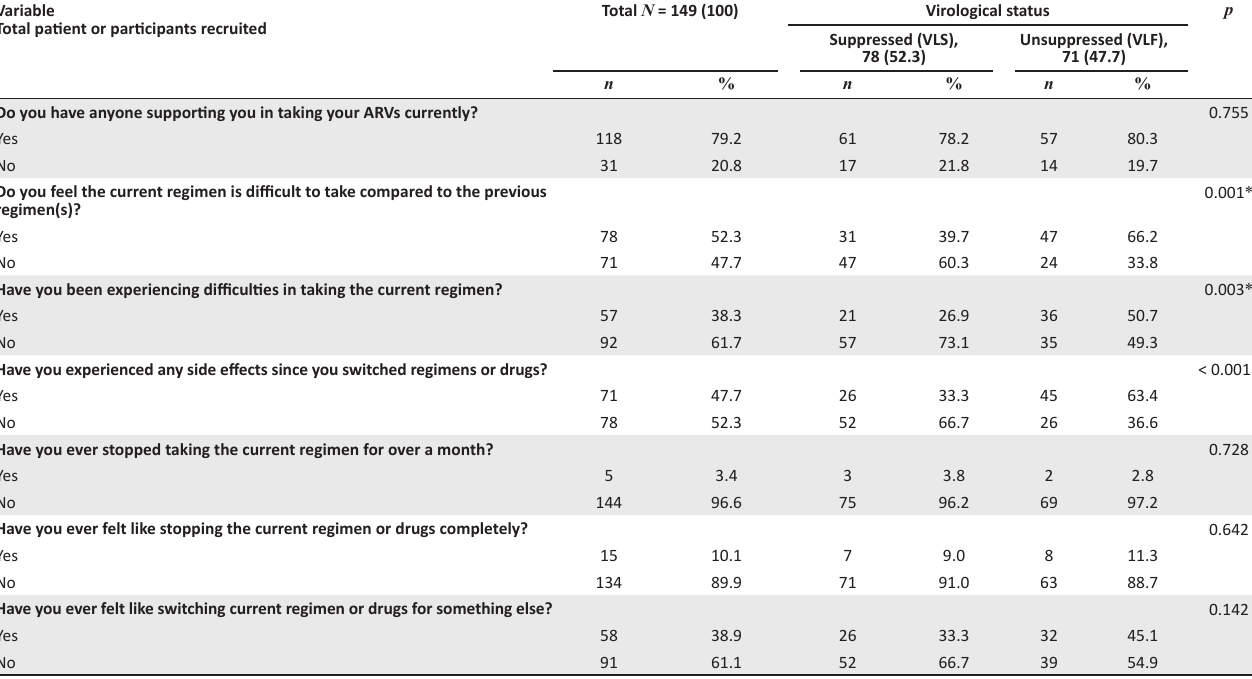
TABLE 1(continuous): Socio-demographic and treatment-taking characteristics disaggregated by virological status of second-line participants in five health facilities in the Johannesburg inner city. Variable Total patient or participants